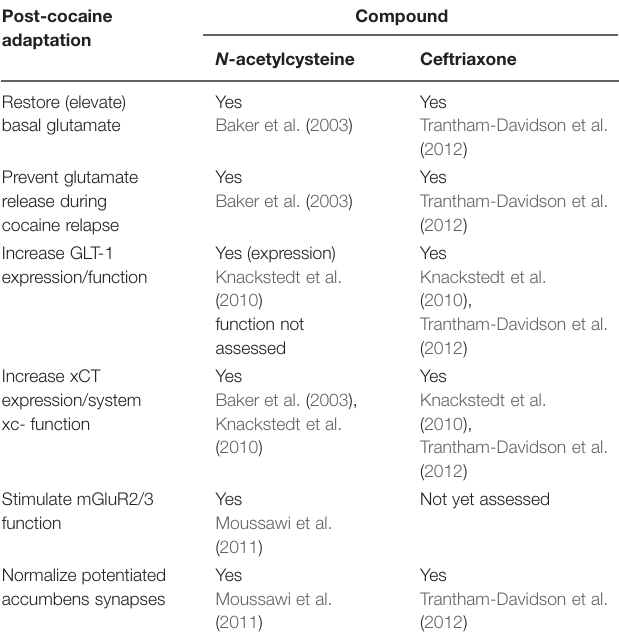
TABLE 1 | Summary of N -acetylcysteine and ceftriaxone effects on cocaine-induced adaptations in the nucleus accumbens. Post-cocaine